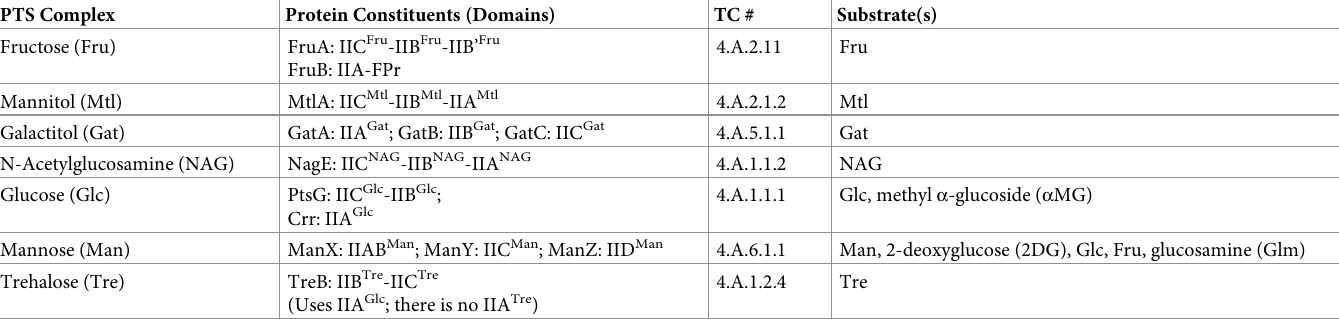
Table 1. Proteins of the PTS in E . coli , relevant to the study reported here. References for these systems can be found in